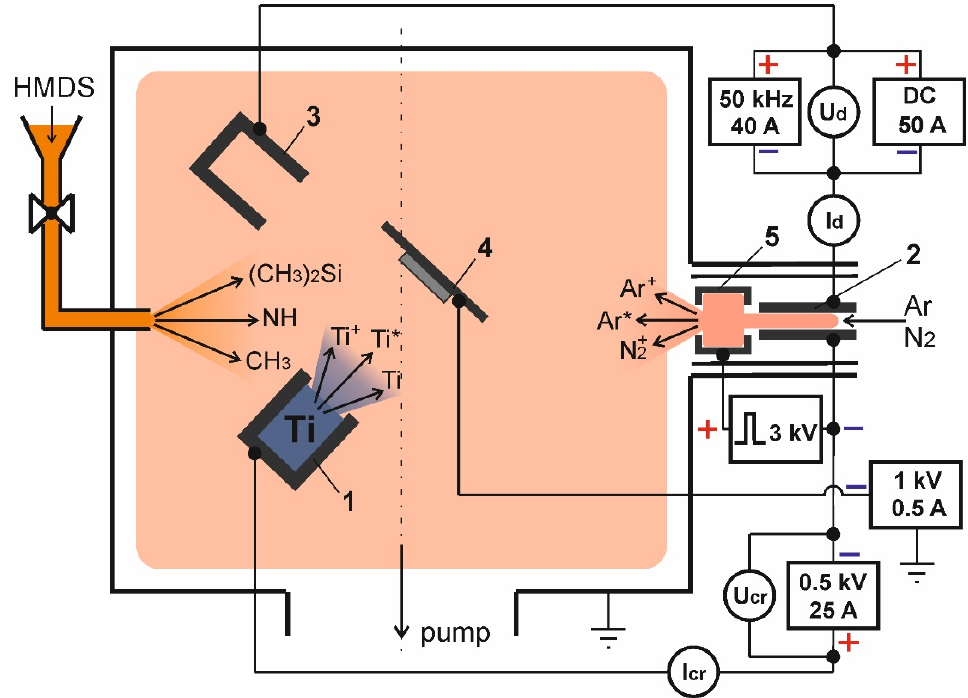
Figure 1. Electrode scheme of experimental facility.